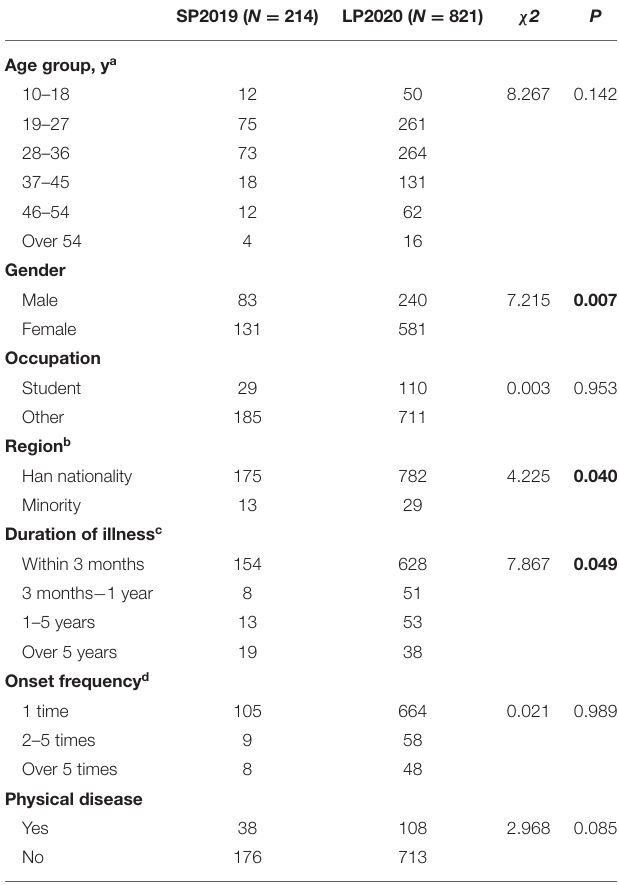
TABLE 1 | Theme of six training sessions for users in the anxiety group and depression group.